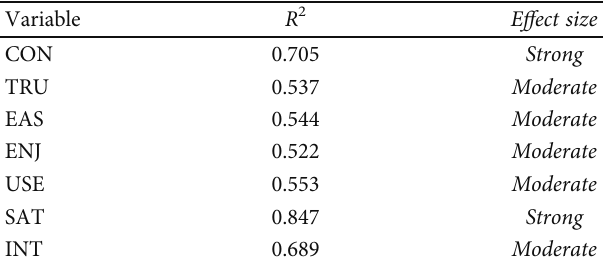
Table 6: R 2 results.